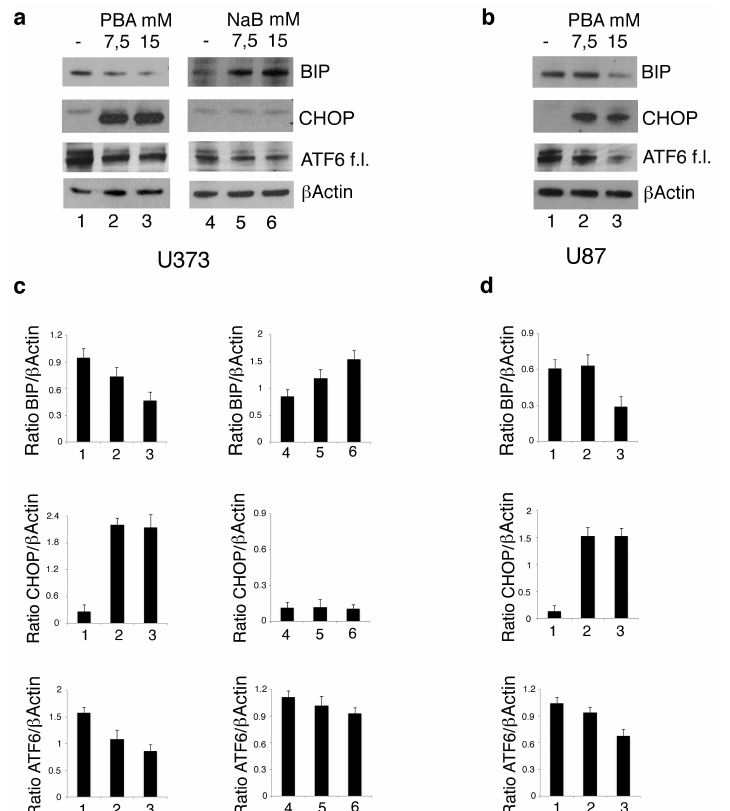
Figure 4. PBA and NaB di ff erently a ff ect the expression of the Unfolded Protein Response (UPR) molecules in U373 cells. U373 ( a ) cell line, cultured in the absence and in the presence of 7.5 mM or 15 mM PBA or in the presence of 7.5 mM or 15 mM NaB, and U87 ( b ) cultured in the absence and in the presence of 7.5 mM or 15 mM PBA for 24 h, were analyzed by Western blot for ATF6, BIP and CHOP expression. β Actin was used as loading control. One representative experiment out of 3 is shown. The histograms represent the mean plus SD of the densitometric analysis of the ratio of ATF6, BIP and CHOP on β Actin of 3 di ff erent experiments performed with U373 ( c ) and U87 ( d